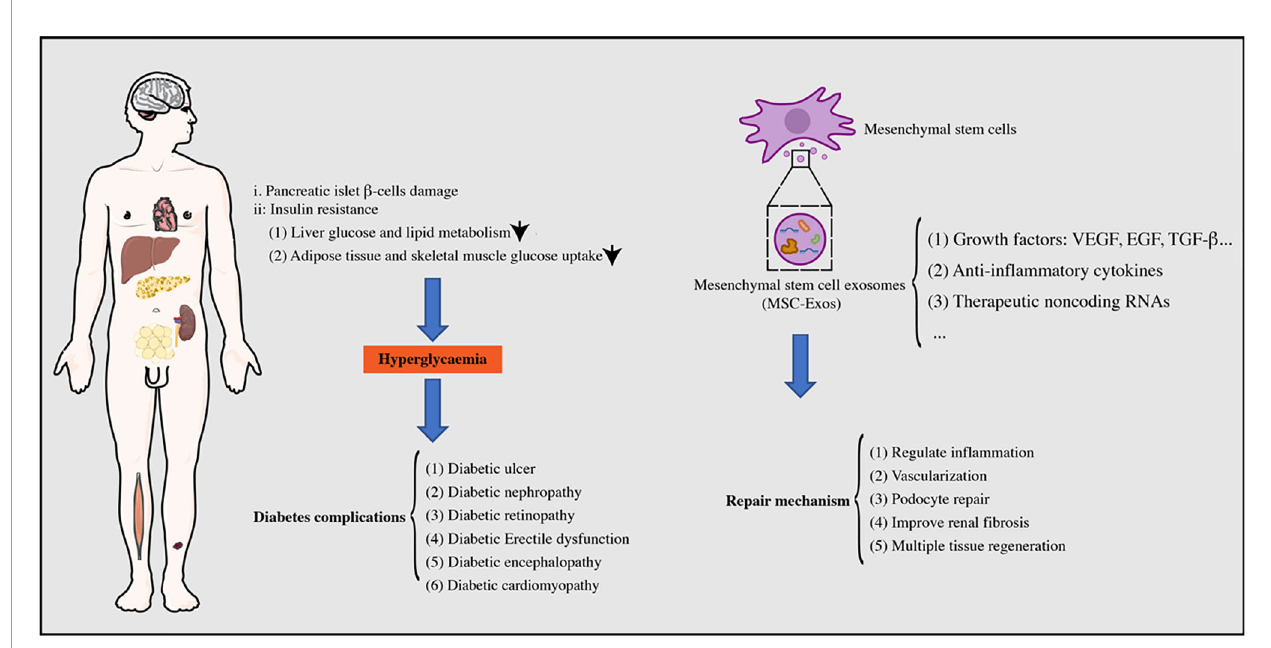
FIGURE 1 | Diabetes/diabetes complications and mesenchymal stem cell exosomes